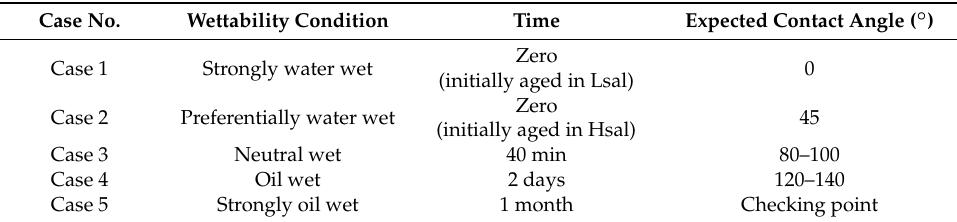
Table 3. Oil aging time for carbonate rock samples with 5 different initial wettability conditions. Case